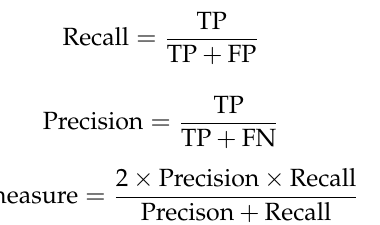
Figure 8. RCF based building edges detection results. ( a1 – a3 ) Original imagery; ( b1 – b3 ) building edges ground truth map; ( c1 – c3 ) building edges probability map generated by RCF-building; ( d1 – d3 ) building edges refinement map generated by NMS algorithm; and ( e1 – e3 ) building edges refinement map generated by involved algorithm.